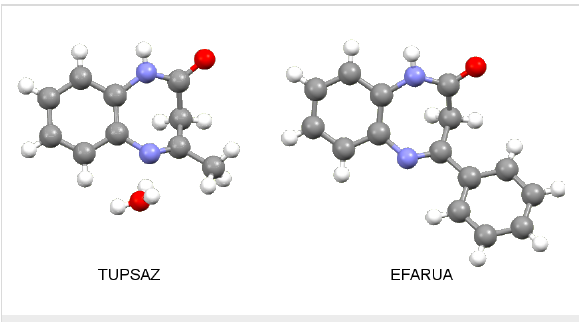
Figure 2: The X-ray structures of 3a (TUPSAZ), 5a (EFARUA). In TUPSAZ there is a disordered water molecule.